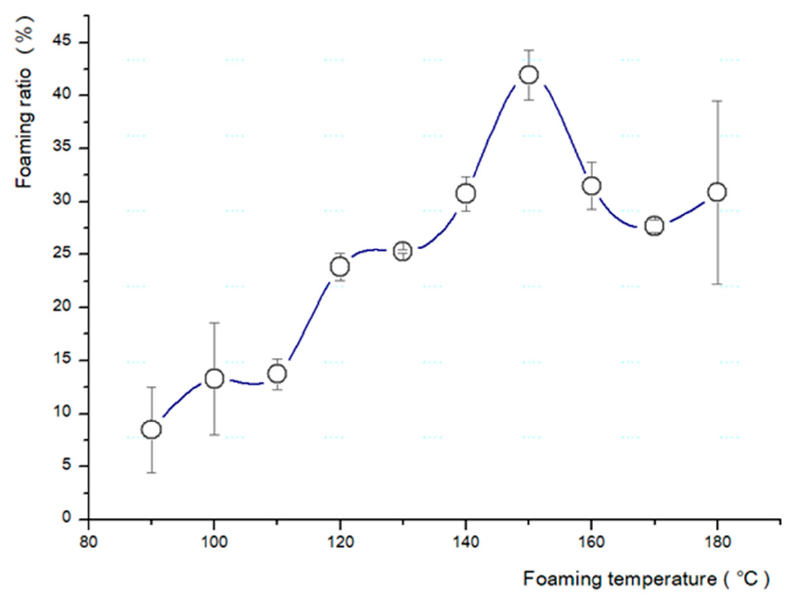
Figure 4. Changes in foaming ratio corresponding to foaming temperature. Table 2. Experimental conditions.